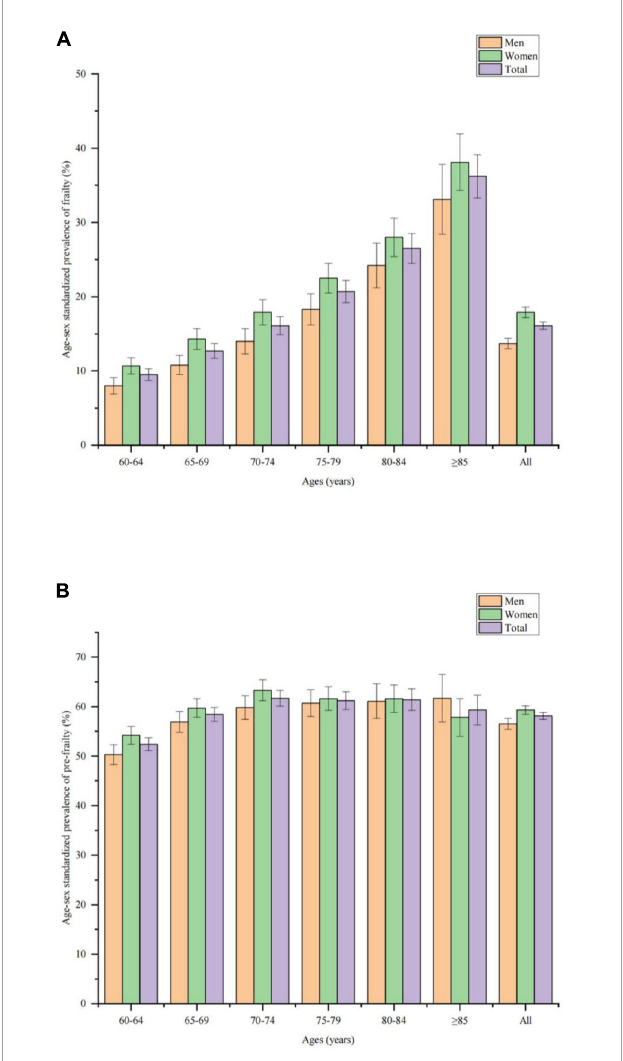
FIGURE2 Age-sex standardized prevalence of frailty and pre-frailty in older adults with hypertension. (A) Age-sex standardized prevalence of frailty among men, women, and all older adults with hypertension. (B) Age-sex standardized prevalence of pre-frailty among men, women, and all older adults with